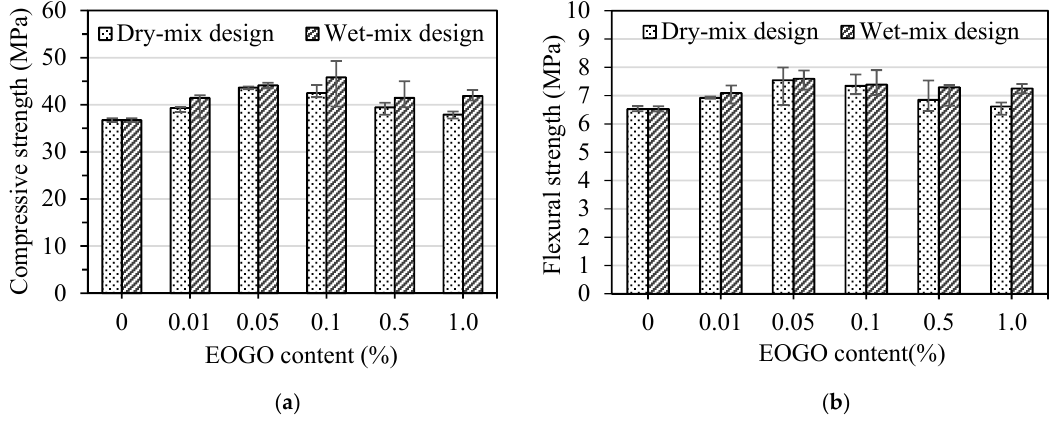
Figure 10. Comparison between the dry and wet-mix design methods of EOGO-mortars: ( a ) Compressive strength at 28 days and ( b ) flexural strength at 28 days.